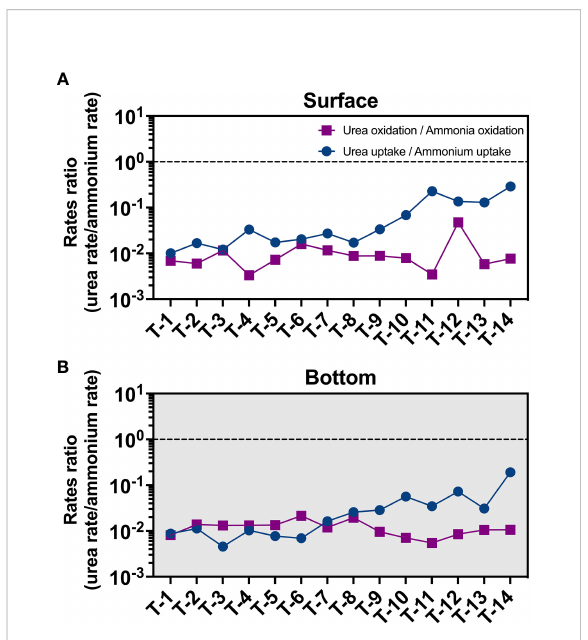
FIGURE 7 Distribution of urea oxidation to ammonia oxidation ratio (purple square) and urea uptake to ammonium uptake ratio (blue circle) in the surface (A) and bottom (B)